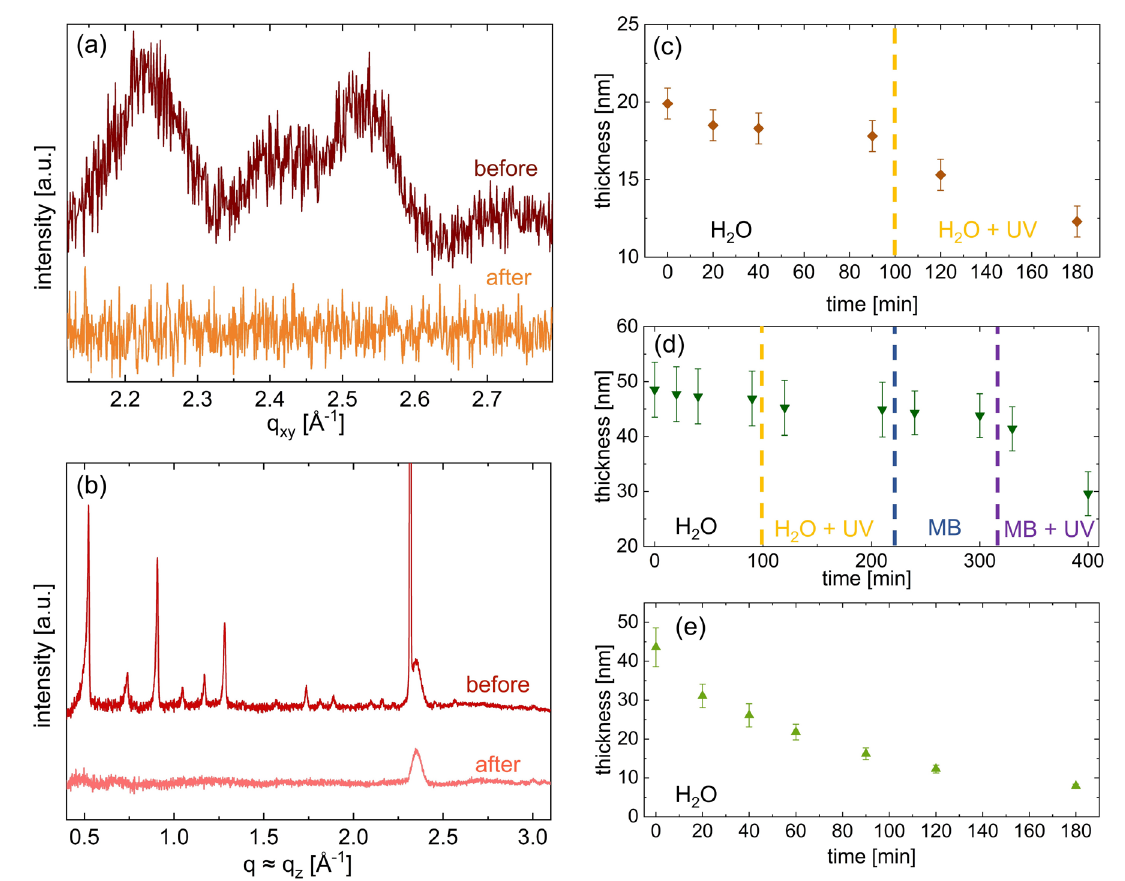
Figure 6. X-ray diffraction pattern of ( a ) porous ZnO obtained from a molecular layer deposited zincone and ( b ) of ZIF-8 converted from porous ZnO before and after photocatalytic tests. Thickness of ( c ) porous ZnO, ( d ) non-porous ZnO deposited via plasma-enhanced atomic layer deposition (PE-ALD), and ( e ) ZIF-8 obtained from PE-ALD ZnO after submersion in water (H 2 O) or in a 10 − 5 mol/L methylene blue (MB) solution, either under ambient conditions or under UV